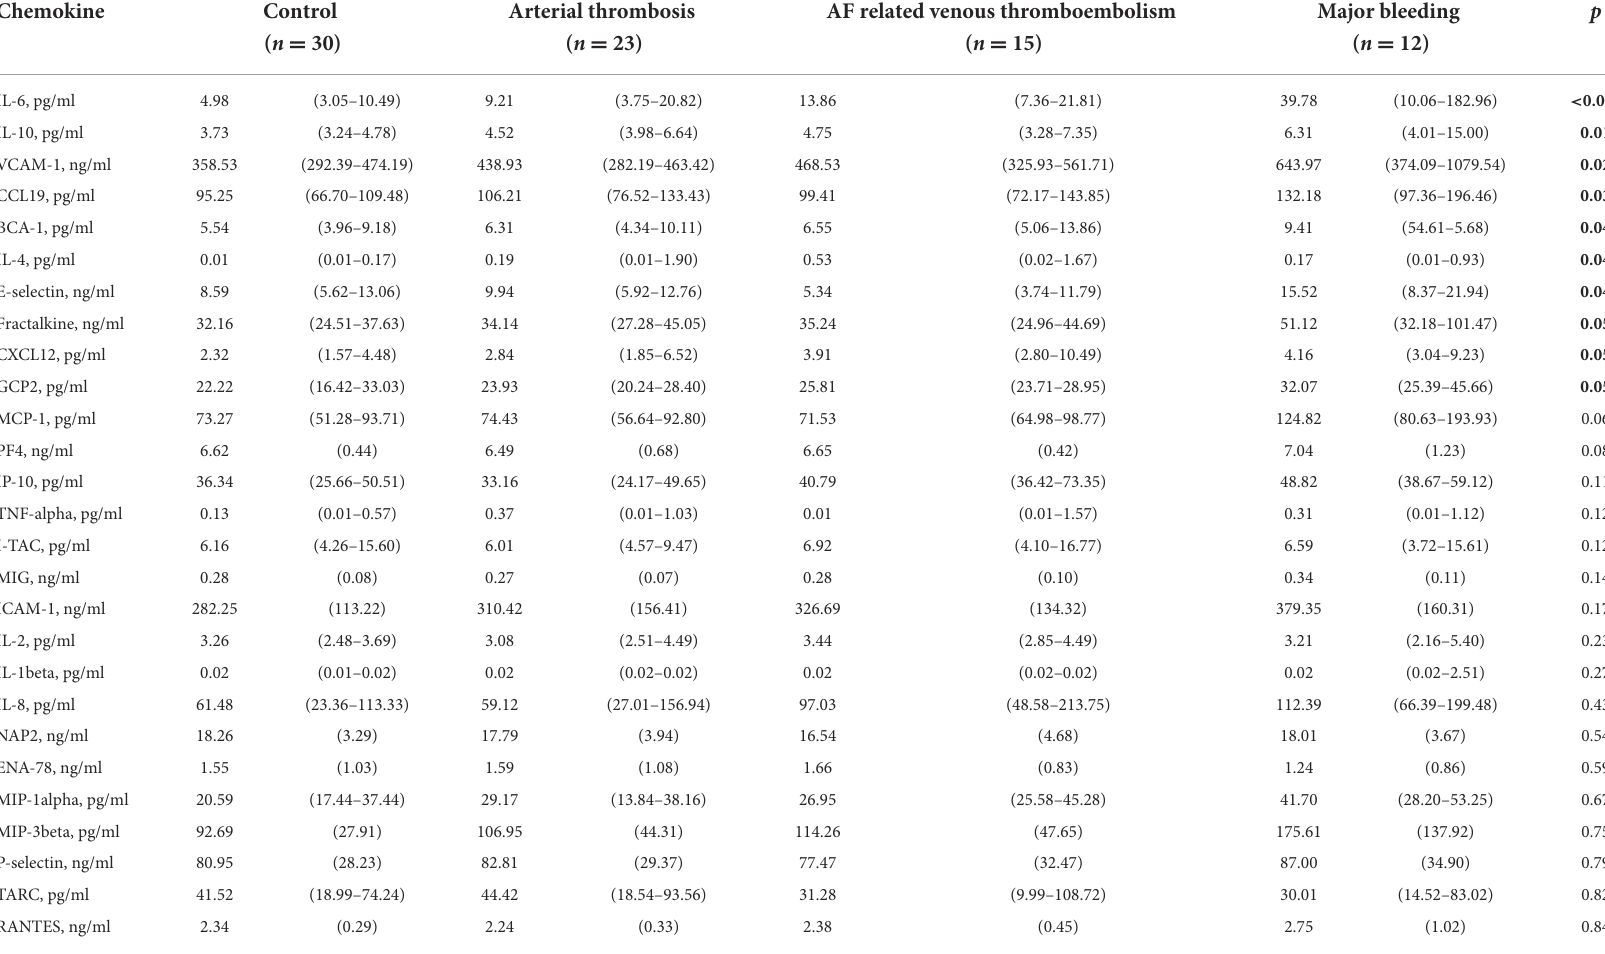
TABLE 3 Levels of chemokines in elderly patients with AF and different adverse clinical